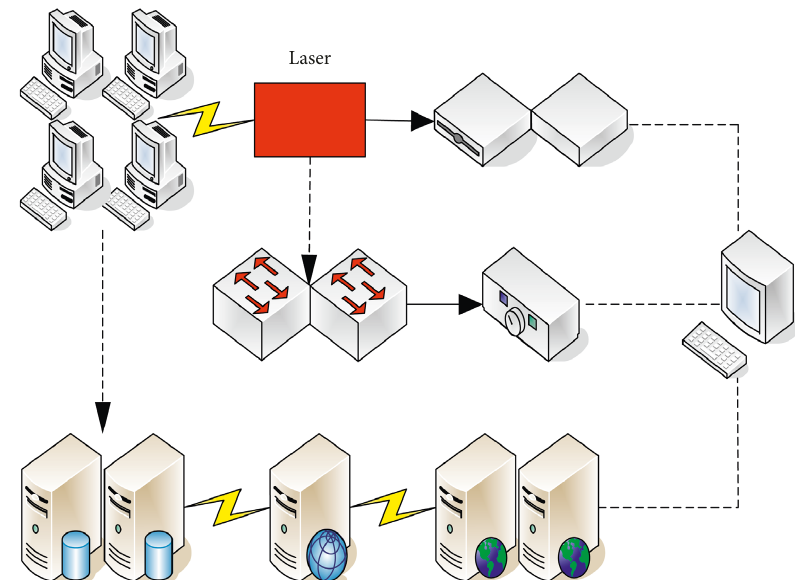
Figure 1: Scattering spectrum.